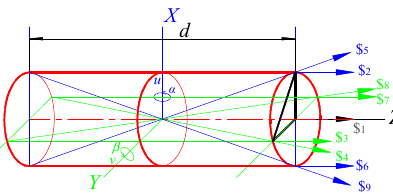
Figure 4. Cylinder tolerance zone and baselines of area coordinate system corresponding to axis TF.